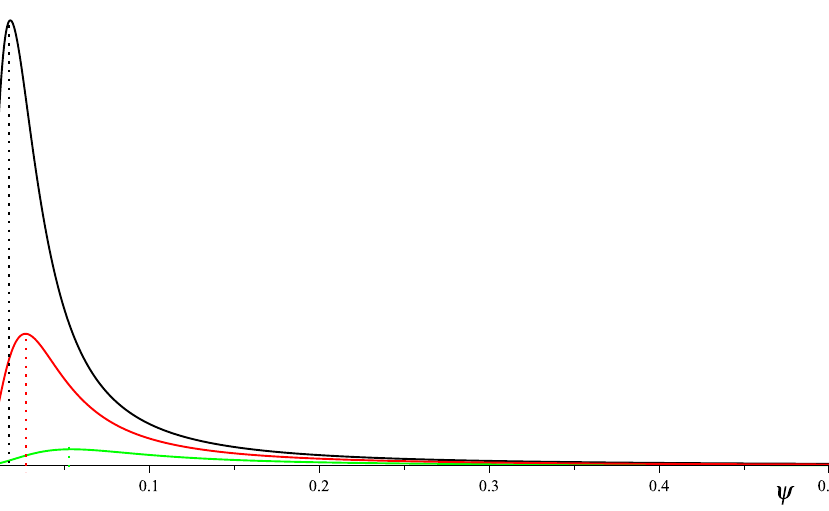
Figure 1 . The angular dependence of the radiation amplitude for (cid:13) = 15 in four (black), (cid:12)ve (red) and six (green) spacetime dimensions (units { 2 (cid:22) E ! (cid:0) 2 = 1 are understood).